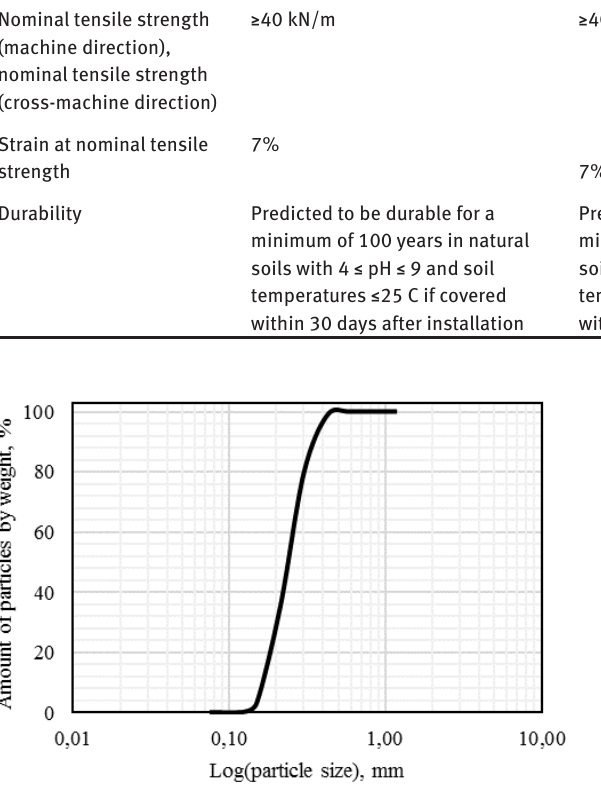
Table 1. The main properties of flexible and rigid geogrids (taken from the technical brochures of suppliers).